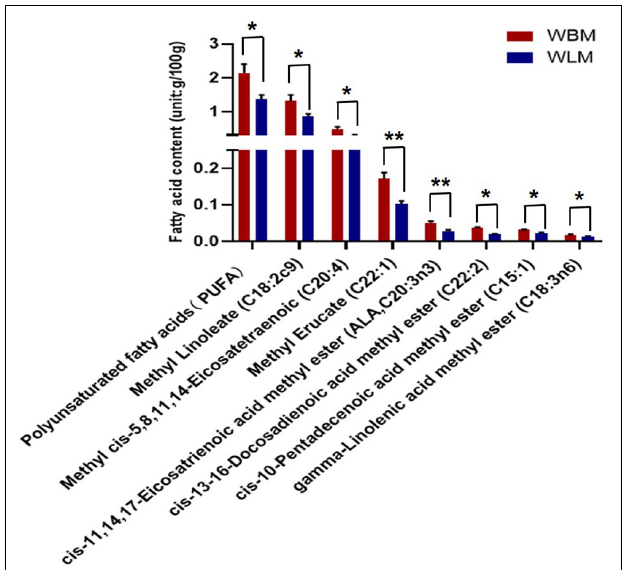
FIGURE 1 | Fatty acid content of longissimus dorsi muscle (WLM) and biceps femoris muscle (WBM). Red represents the high-fatty acid group (the WBM tissue group), while blue represents the low-fatty acid group (the WLM tissue group). The asterisks represent the levels of significance ( t -test: * P < 0.05, ** P <